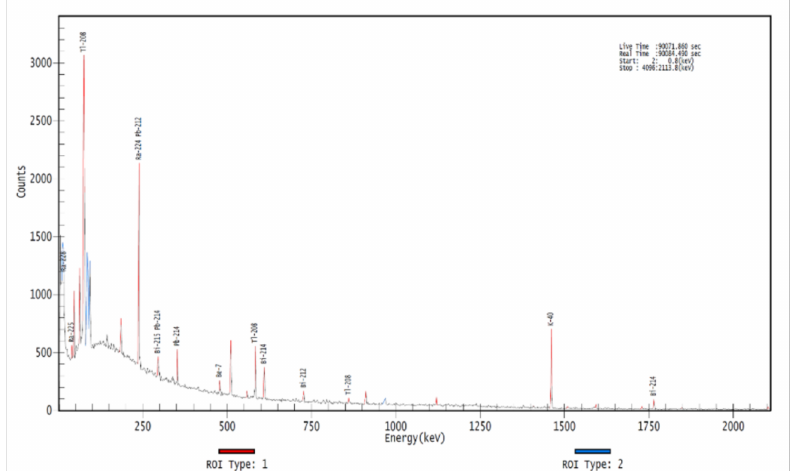
Figure 13. Gamma spectroscopy on BF